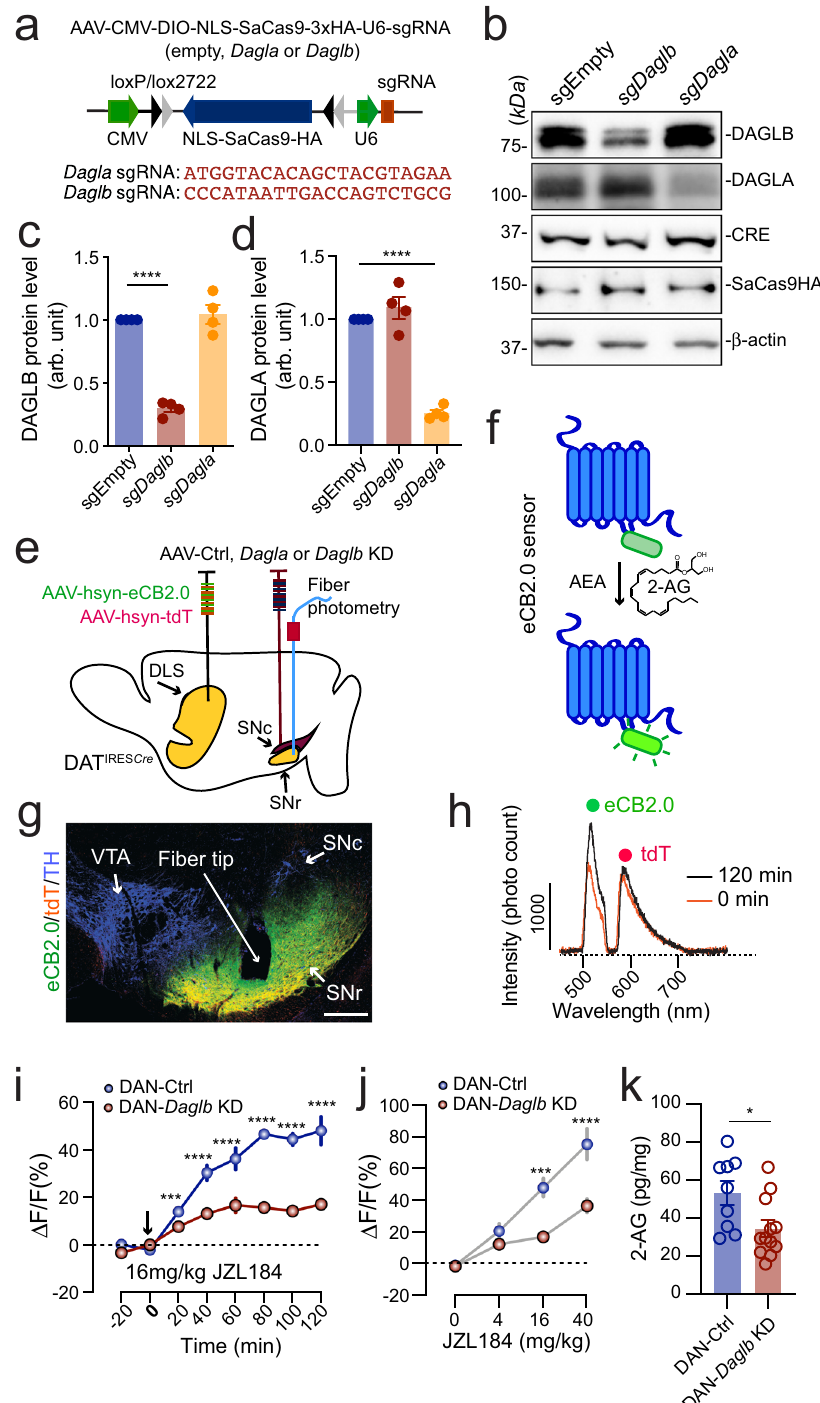
month-old DAT IRESCre mice with AAV vectors and compared the SN 2-AG levels in DAN-Ctrl and DAN- Daglb KD mice during rotarod tests (Fig. 5a). We found that the increase of eCB2.0 signals was substantially diminished in the SN of DAN- Daglb KD mice compared to the DAN-Ctrl mice, especially in the later trials on days 1 through 5 across the training sessions as compared to the DAN-Ctrl ones (Fig. 5b). To examine the behavioral consequence of diminished 2-AG signaling in DAN- Daglb KD mice, we compared the rotarod performance between DAN-Ctrl and DAN- Daglb KD mice. Although the DAN- Daglb NATURE COMMUNICATIONS| (2022) 13:3490